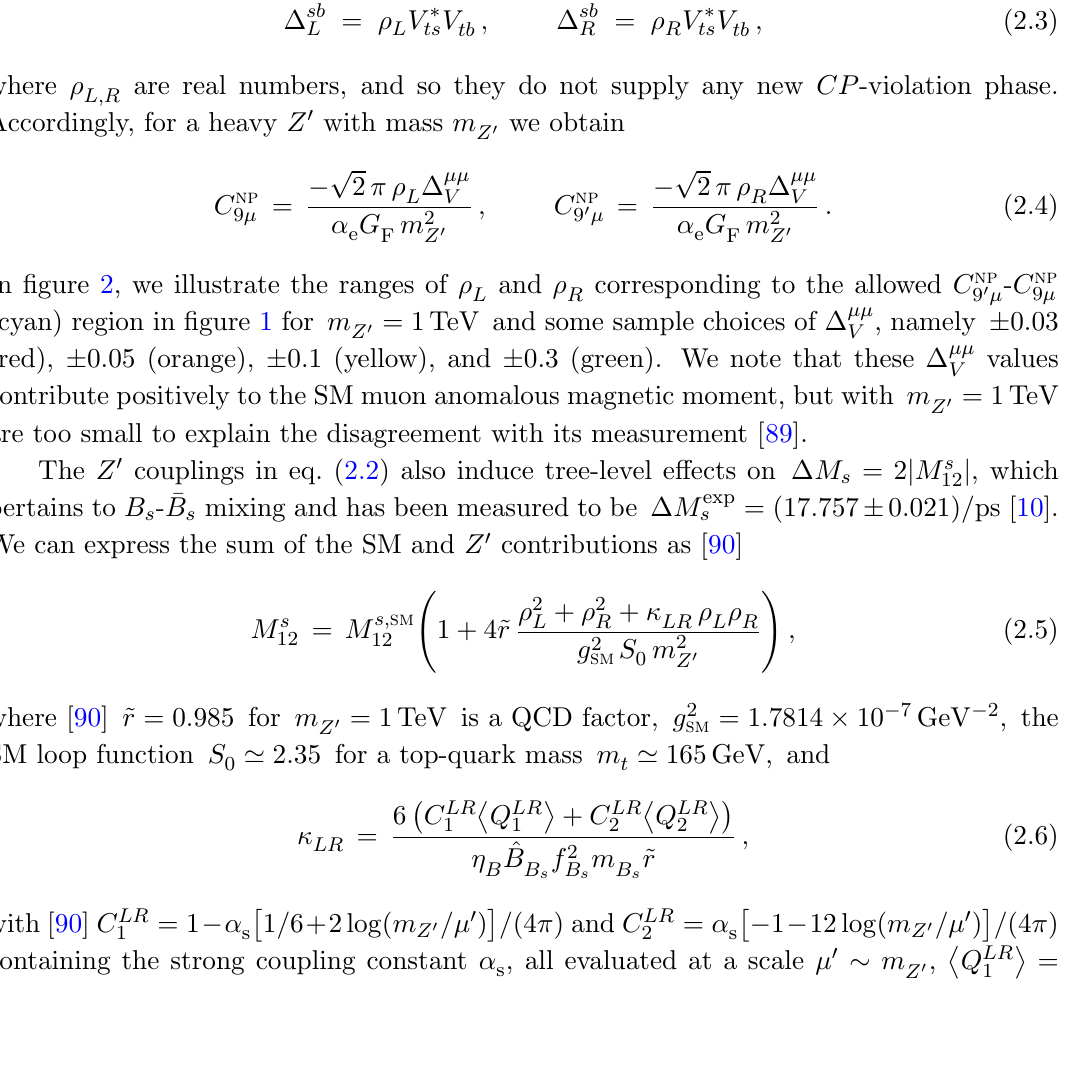
Figure 2 . Regions of (cid:26) constraint depicted in (cid:12)gure 1 for (cid:1) (cid:22)(cid:22) (green). The blue area ful(cid:12)lls the condition in eq. (2.7) from B s - (cid:22) B s mixing